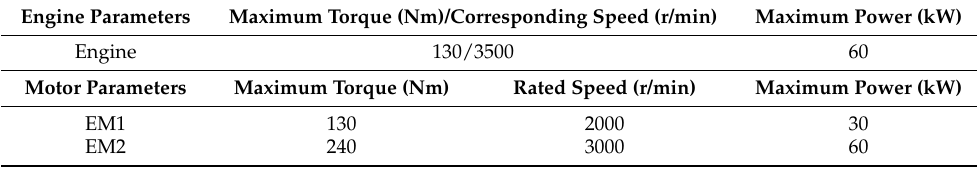
Table 2. Important power system parameters for simulation.